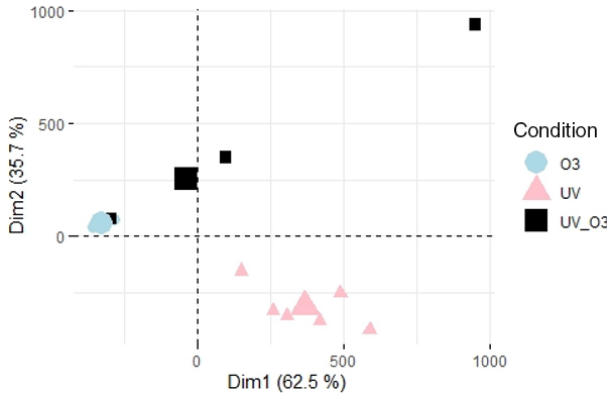
Figure 4. VOC profiles differences between UV light, UV_O 3 , and O 3 conditions; each point represent 1d measurement. The percent- age of the variance explained by the two first components is shown on each axis (Dim1 and